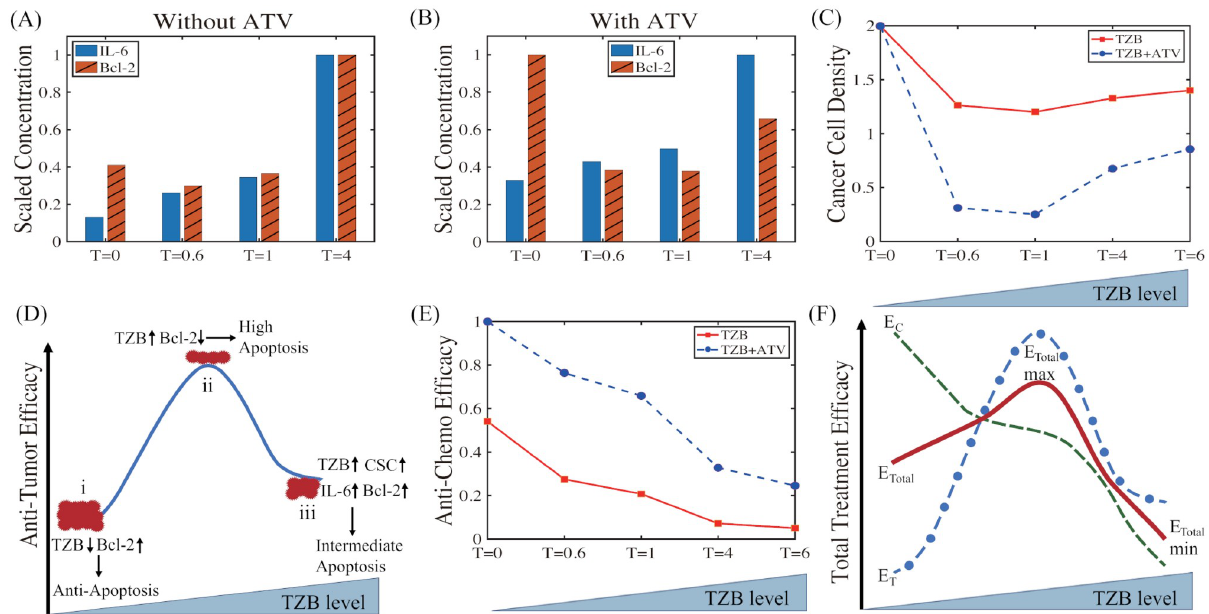
Fig 7. Nonlinear dynamics of the system in response to TZB treatment. (A,B) IL-6 and Bcl-2 levels at 30 days post treatments in response to various TZB doses ( T = 0, 0.6, 1.0, 4.0) in the absence (A) and presence (B) of ATV adjuvant therapy. � The values in (A) were normalized against the case with T = 4, and the IL-6 and Bcl-2 values in (B) were normalized against T = 4 and T = 0, respectively. (C) Cancer cell density corresponding to (A,B). (D) A model depicting the impact of TZB and ATV combination therapy on anti-tumor efficacy ( E with single (solid red square; TZB) and combination therapy (blue dotted circle; TZB+ATV) for various TZB doses ( T = 0, 0.6, 1.0, 4.0, 6.0). (F) Schematic of total treatment efficacy ( E ; red solid curve) of the combination therapy based on E Total ω 2 E c with ω 1 = ω 2 = 0.5. � ATV level in (B-F) is fixed ( A = 5.0). Other parameters are given in Table 1.